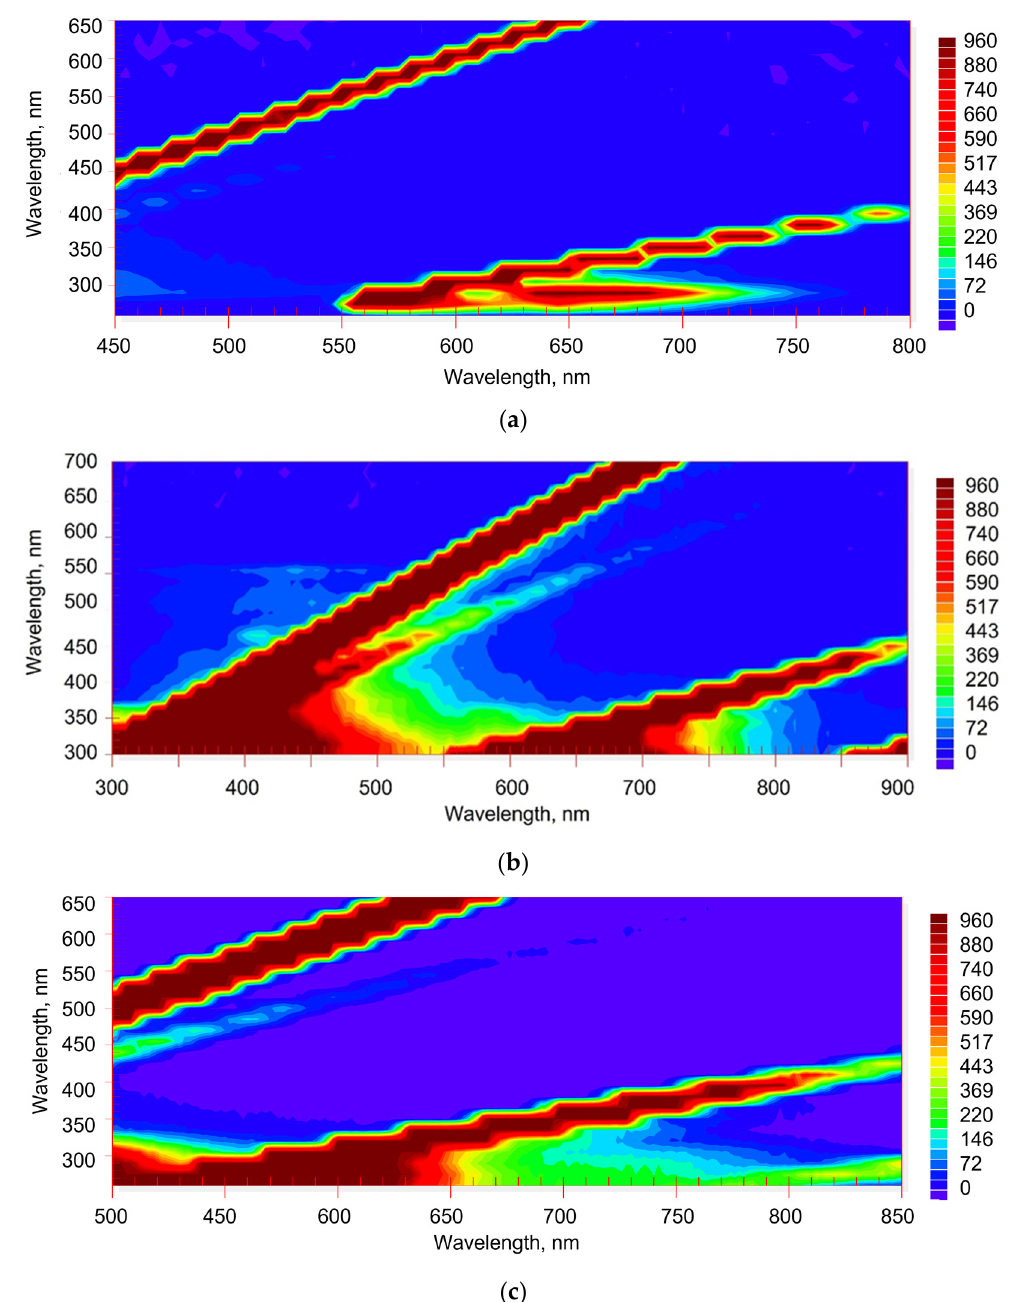
Figure 1. Excitation–emission fluorescence maps of solvents: ( a ) benzene, ( b ) toluene, and ( c ) n -hexane. Excitation/emission slits, 10/10; 20/20; and 20/20 nm, respectively; detector voltage, 860, 930, and 850 V, respectively; scanning pitch, 15 nm. Y -axis is excitation, X -axis is emission. The lines corresponding to 1st-, 2nd-, and 3rd-order Rayleigh and 1st- and 2nd-order Stokes Raman scattering are diagonal swaths in the